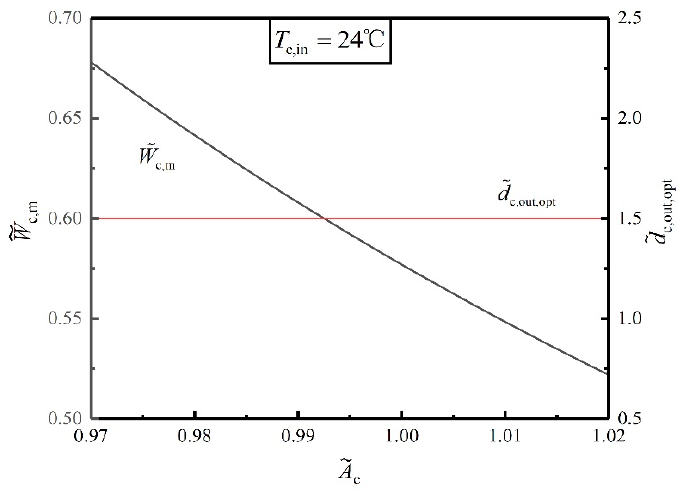
Figure 7. Influences of (cid:101) A c on the (cid:101) W c , m and (cid:101) d c , out , opt .